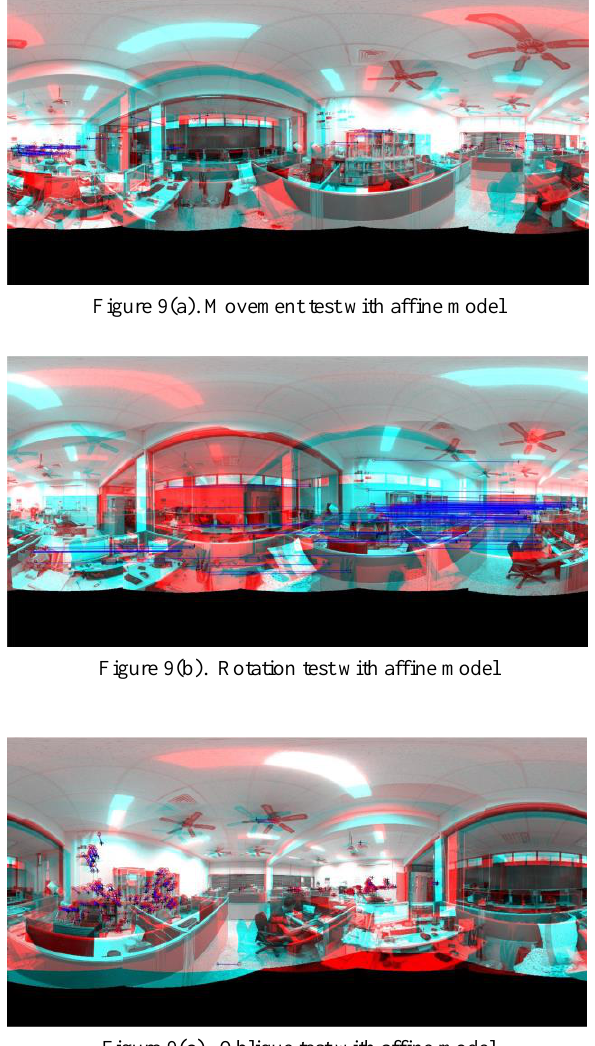
Figure 9(c). Oblique test with affine